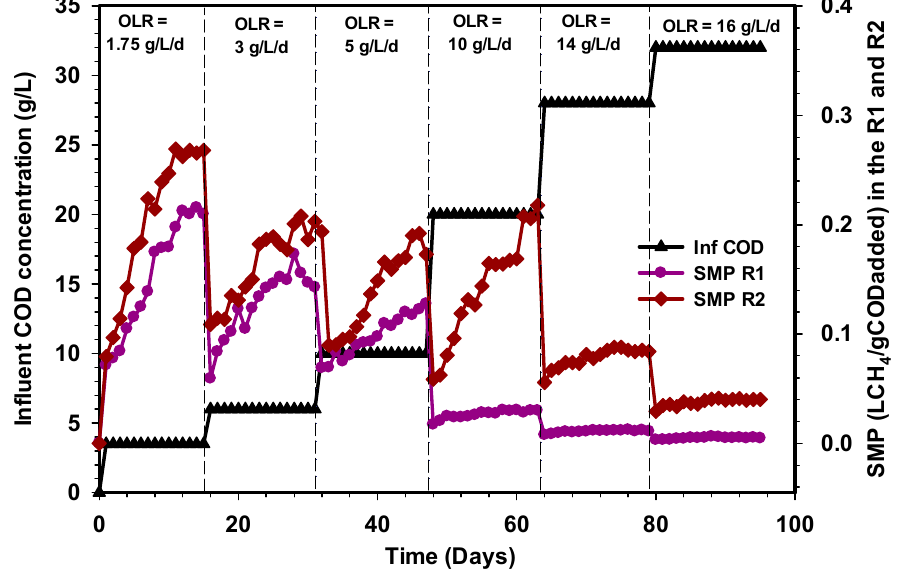
Figure 4. Variation of specific methane production (SMP) in the R1 and R2 reactors .